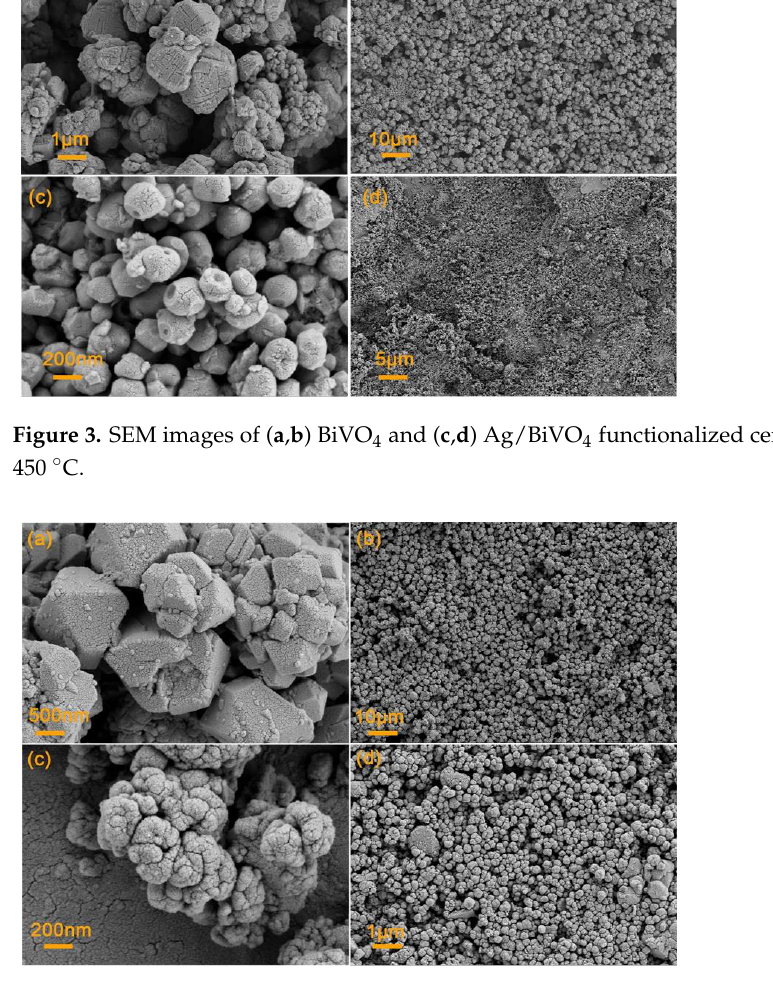
Figure 5. SEM images of ( a , b ) BiVO 4 and ( c , d ) Ag/BiVO 4 functionalized ceramic tiles obtained at 650 °C. Figures S7–S9 show the AFM images of the samples obtained at different tempera- tures. At 450 °C, the roughness (estimated by arithmetical mean deviation of the profile ( Ra )) of CB and CSB was 70.2 nm and 141 nm, respectively. When the temperature in- creased to 550 °C, the roughness of the two samples increased to 117 nm and 162 nm, respectively. When the temperature increased to 650 °C, the roughness decreased to 100 nm and 117 nm, respectively. Studies have shown that the agglomeration and particle size of photocatalytic materials affect their parameters. When a material agglomerates or melts into larger particles, the roughness of the coating will increase [28]. The SEM results show that when the temperature increased from 450 °C to 550 °C, the photocatalytic particles agglomerated, which increased the surface roughness of the coated ceramic tiles. As the temperature increased to 650 °C, the roughness decreased. The reason is that the photo- catalytic particles on the surface of the ceramic tiles melted at high temperatures, and the voids between the materials gradually decreased, which decreased the roughness of the coating. Compared with CB, the CSB coating had a much higher roughness for the hybrid